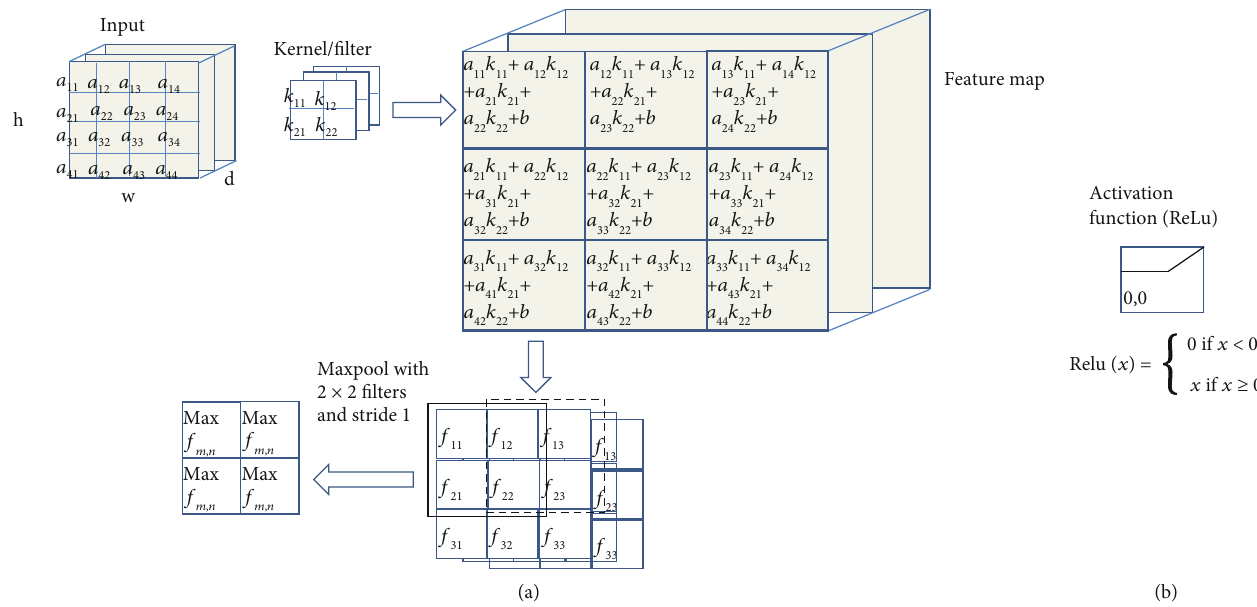
Figure 1: Creating the (a) convolution layer is the function of the convolution layer and pooling, which contains the import image and fi lter feature map obtained by fi nding the relationship between the images imported to the kernel; then, reducing the size by pooling using a (b) 2 × 2 fi lter is an example of the performance of the ReLu activation function. This function is inserted in the convolution process to send the learning value back as far as possible.